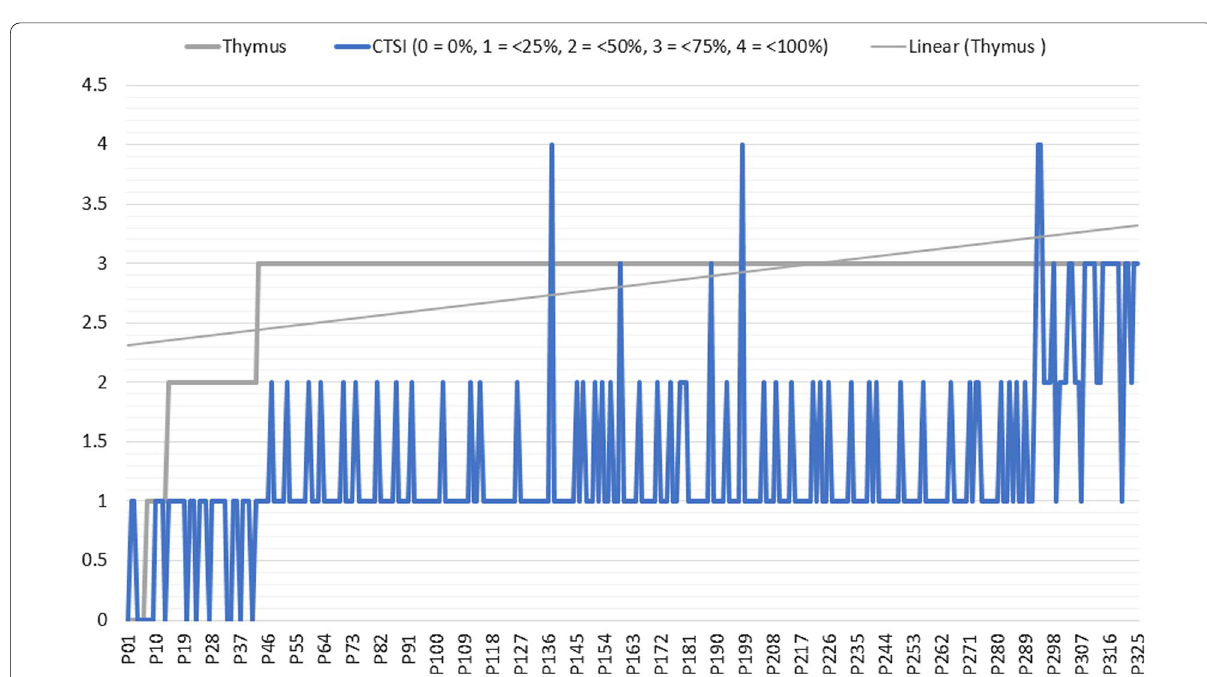
Fig. 8 Bivariate chart demonstrating the distribution frequency and linear relation between thymic CT-score and lung CT-severity score: High CT-severity scores occur more with grade III thymic